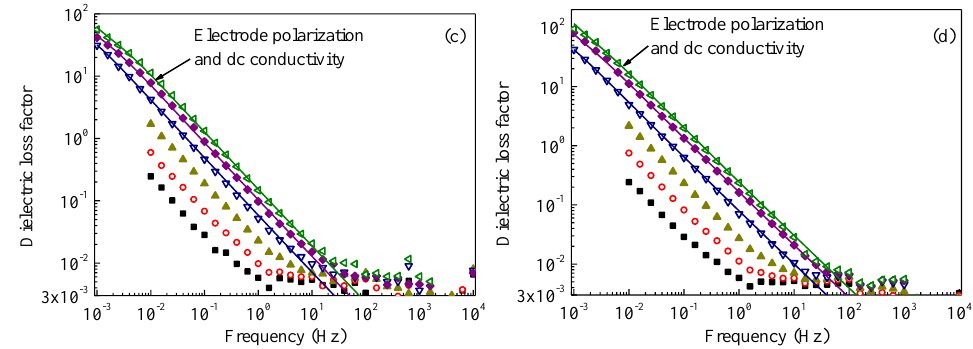
Figure 4. Dielectric constant r ′ and dielectric loss factor r " each as a function of frequency, measured at various temperatures. Dielectric constant r ′: ( a ) irradiated at 185 °C for 900 h and ( b ) irradiated at 185 °C for 1500 h. Dielectric loss r ": ( c ) irradiated at 185 °C for 900 h and ( d ) irradiated at 185 °C for 1500 h. Symbols and solid curves represent the data obtained experimentally and numerically, respectively. The measurements were conducted at 100 °C ( ), 120 °C ( ), 140 °C ( ), 160 °C ( ), 180 °C ( ), and 200 °C ( ).